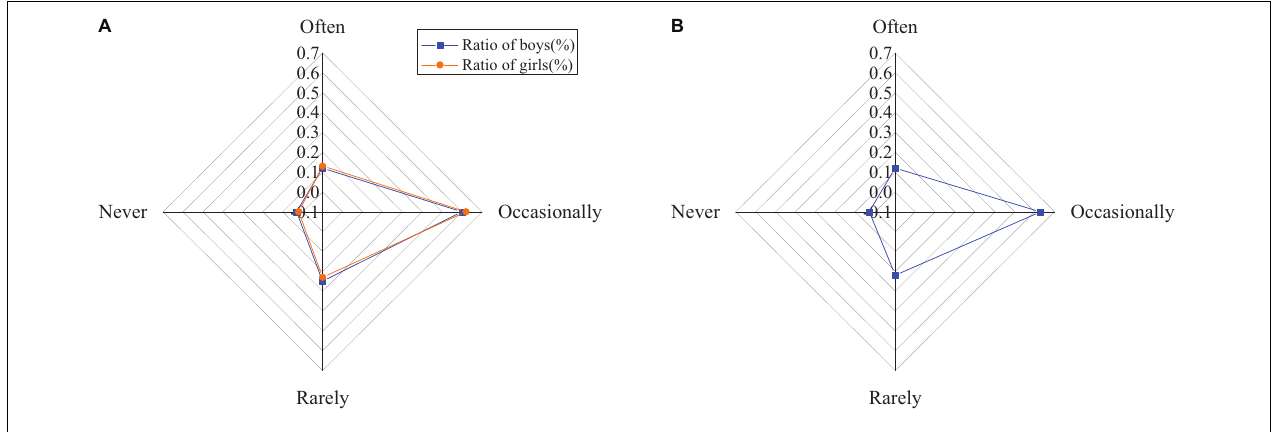
FIGURE 16 | Help of psychological education to college students [ (A) the ratio of males and females; (B) the ratio of all].